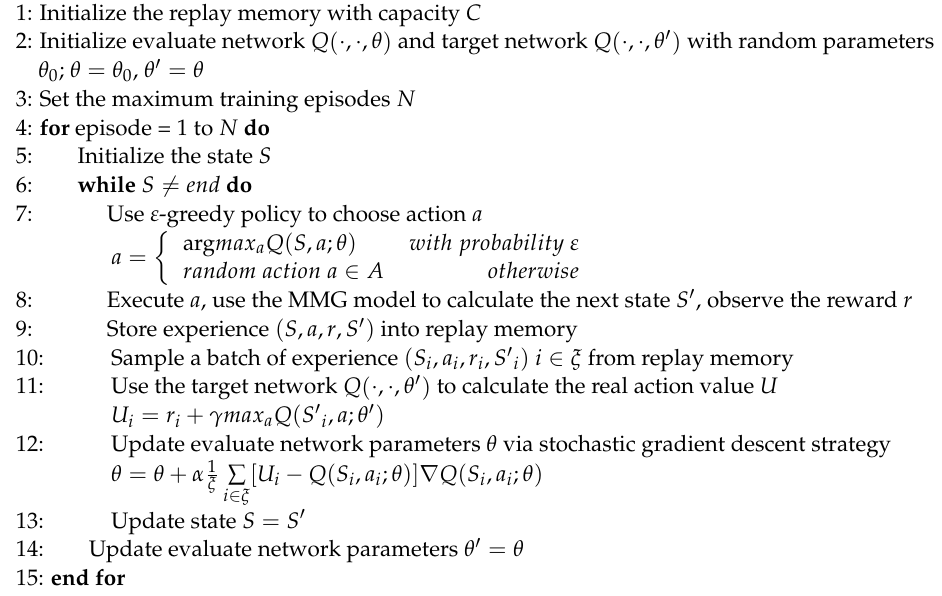
Algorithm 1: The pseudocode of the DQN algorithm: Collision avoidance based on the